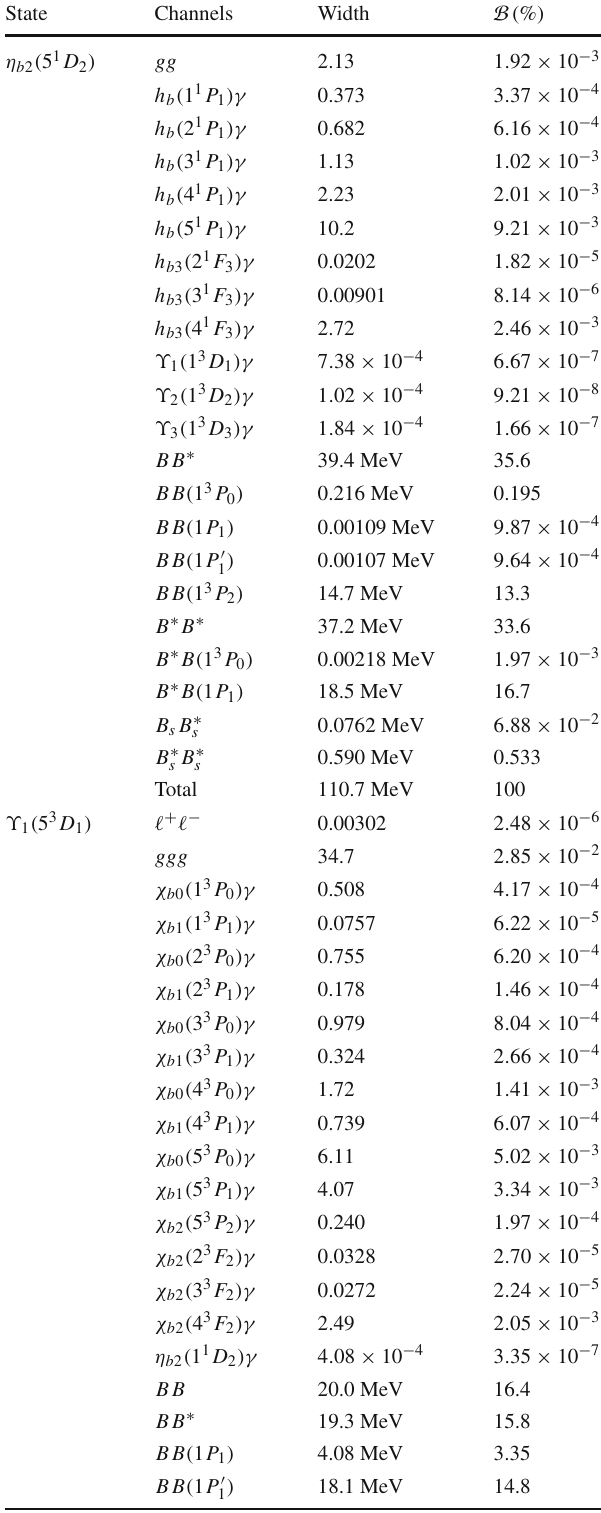
Table 31 Partial widths and branching ratios of OZI-allowed strong decay, annihilation decay, and radiative transition and total widths for 5 1 D 2 and 5 3 D 1 bottomonium states. The width results are in units